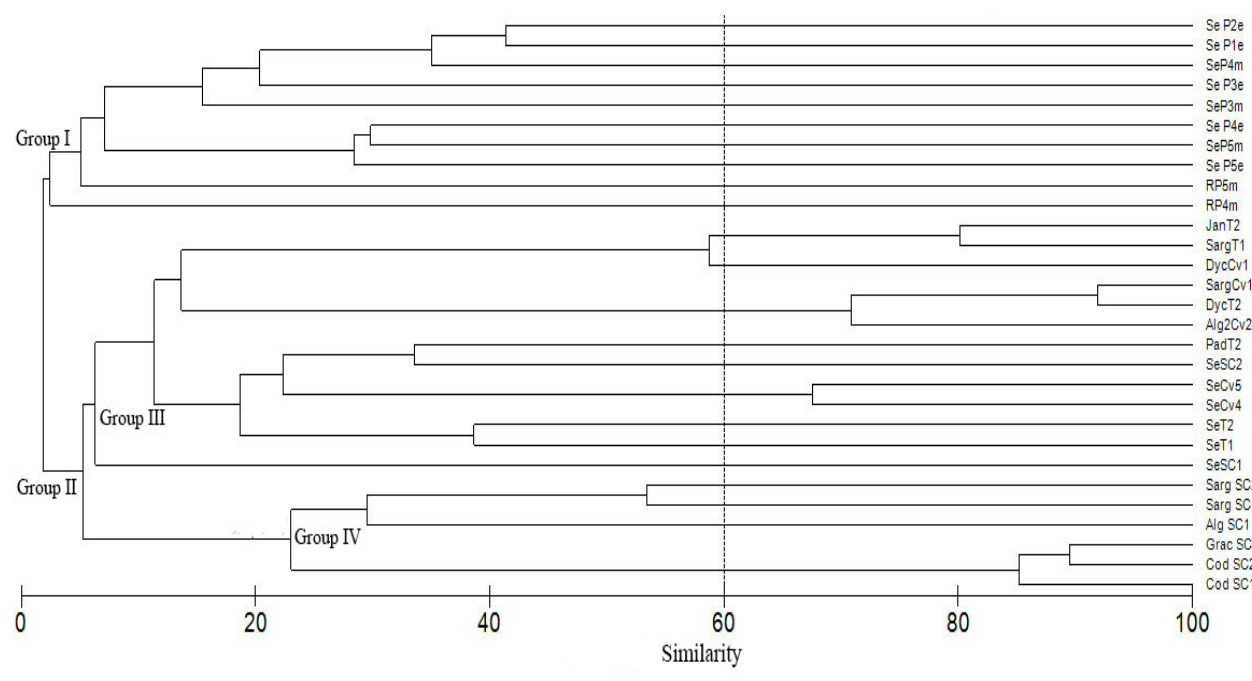
Figure 4. Bray-Curtis similarity between benthic diatom associations from SR and CS using relative abundances of the diatom taxa. P = Port, T = Tanques, Cv = Cuevas, CS = control site, R = rock, Se = sediment, Jan = Jania , Sarg = Sargassum , Dyc = Dyctiota , Pad = Padina , Grac = Gracilaria , Cod = Codium .